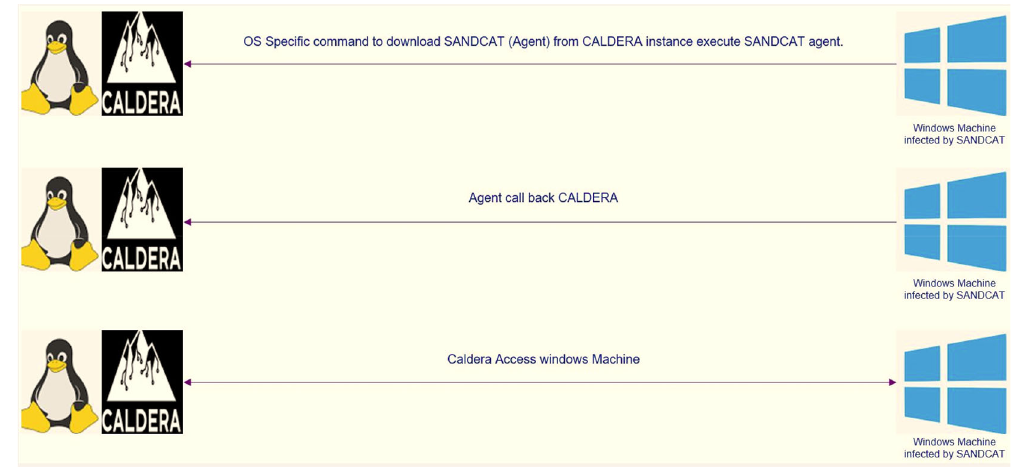
Figure 1. SANDCAT methodology